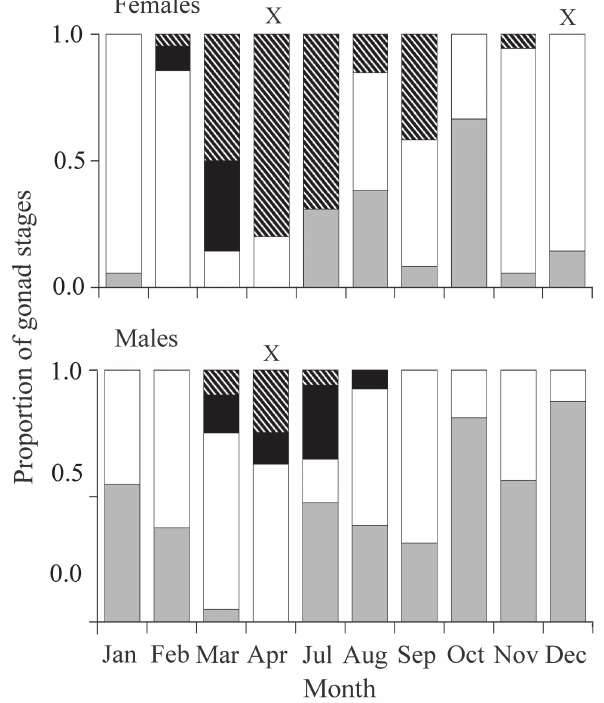
Fig. 4. Boxplots showing monthly distributions of the gonadosomatic index for females and males Pinguipes brasilianus . The lower case letters identify homogeneous groups based on the sequential rejected Bonferroni contrasts among levels for the factor ‘month’ (letter displays were obtained with the package multcompView, R software [R Development Core Team, 2014]). W/d: without